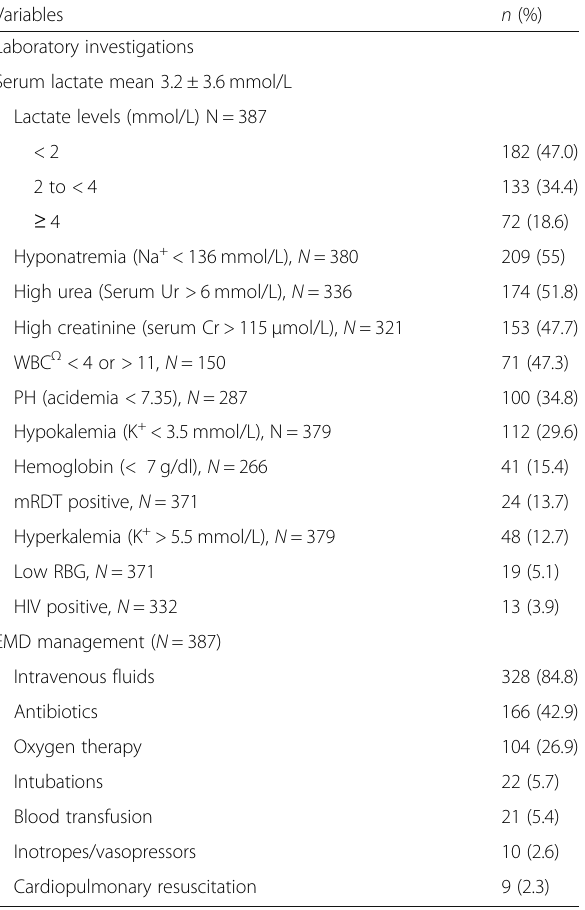
Table 3 Patient ’ s EMD laboratory investigations and Table 2 Patients baseline variables and clinical characteristics